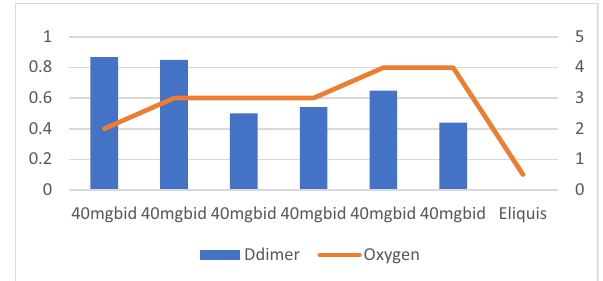
Figure 2: Patient number 2 presented at early stage requiring nasal canula oxygen and D - dimer level was also moderately low on pre - sentation. The fi gure demonstrates that increase or decrease in D - dimer is associated with increasing and decreasing trends of oxygen requirements. In this case, only two D - dimer levels were available. This patient was treated with intermediate dose of Enoxaparin ( 40 mg SubQ BID ) which is higher than DVT prophy - laxis dose.